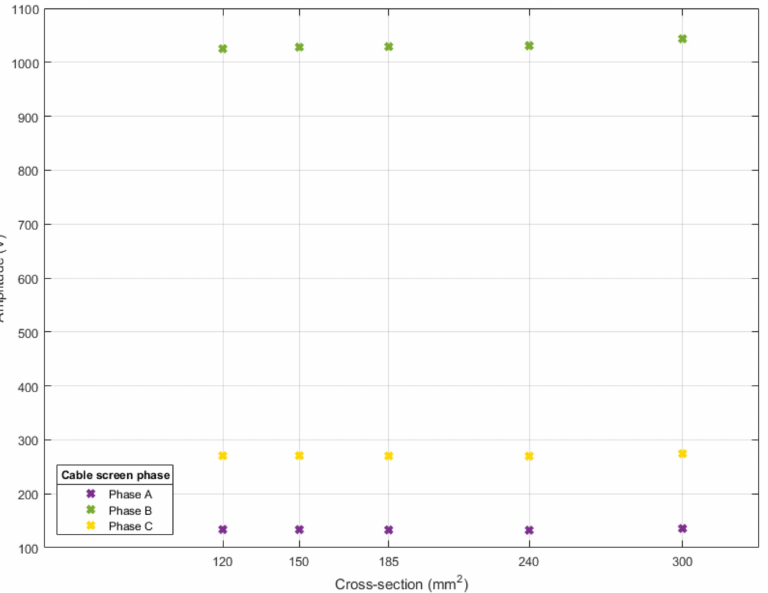
Figure 8. Maximum overvoltage in Terminal J for different conductor cross-sections during a ground fault in phase